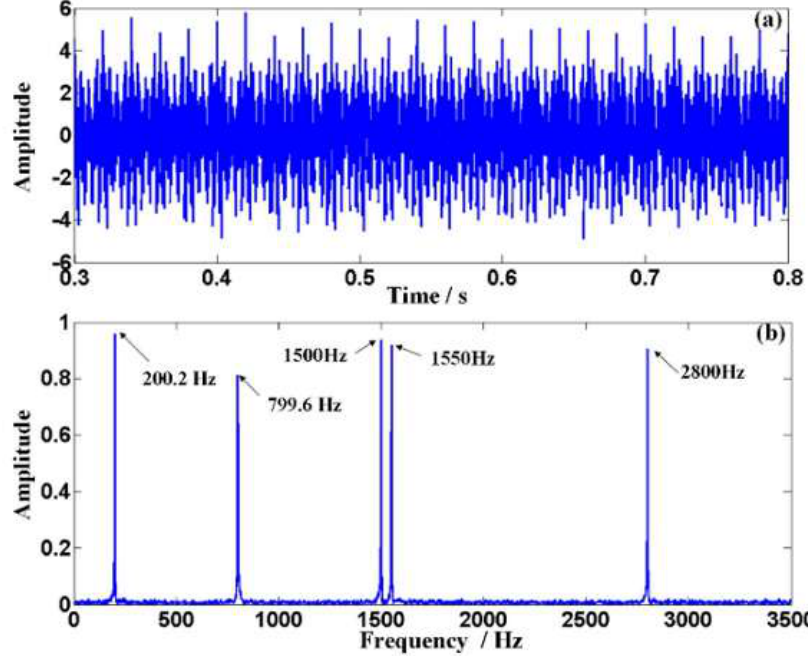
Figure 9. ( a ) The waveform of the restored signal via the ODEE method; ( b ) the spectrum of the restored